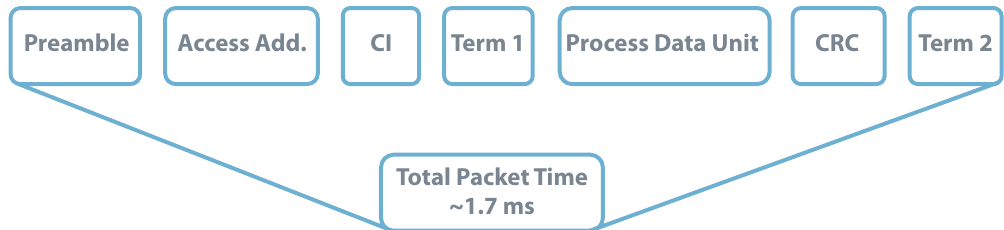
Figure 20. BLE Packet Structure-Payload = 16 bytes. Data from source [138].